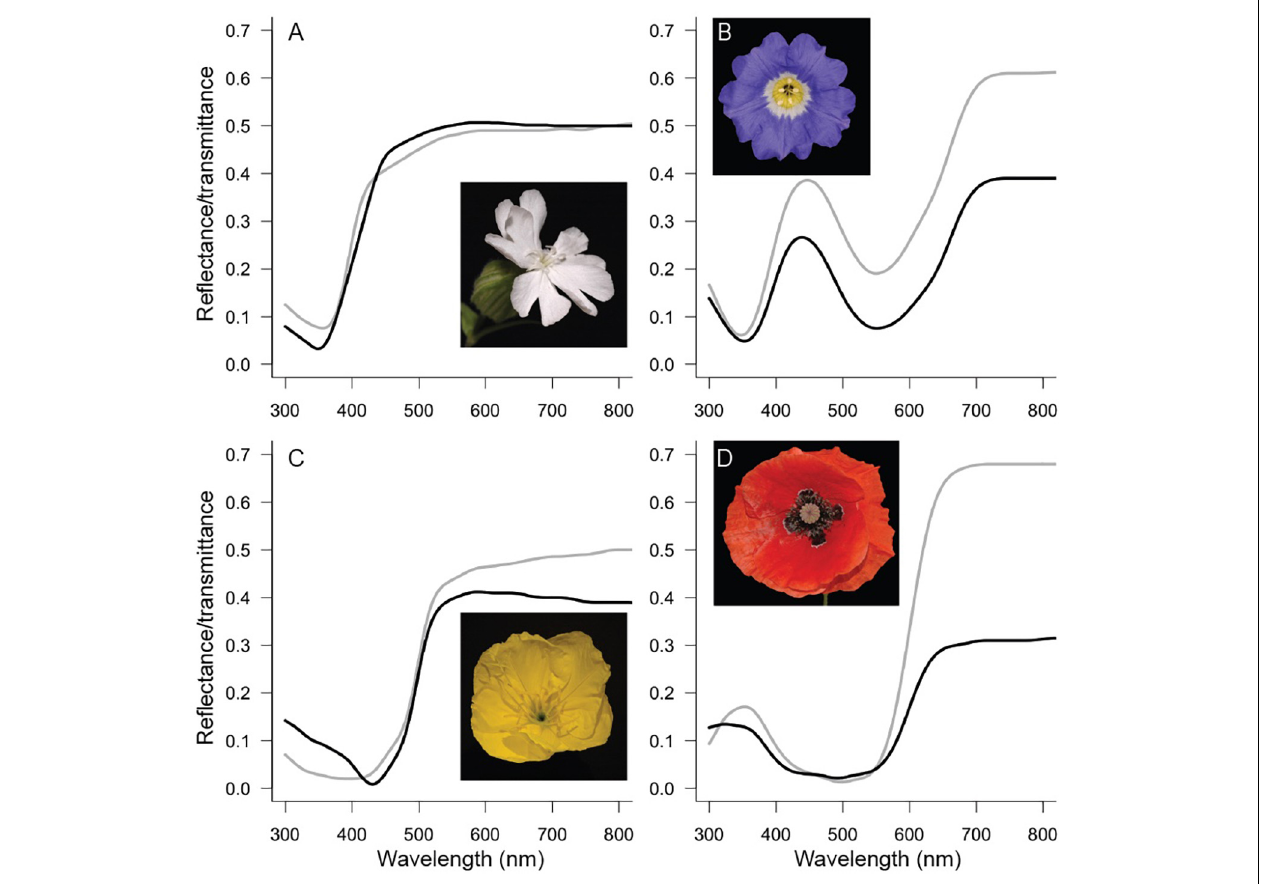
FIGURE 2 | Flowers investigated in this study. Measured reflectance (black curves) and transmittance (gray curves) spectra for Silene latifolia (A), Nolana paradoxa (B) , Oenothera macrocarpa (C) , and Papaver rhoeas (D)